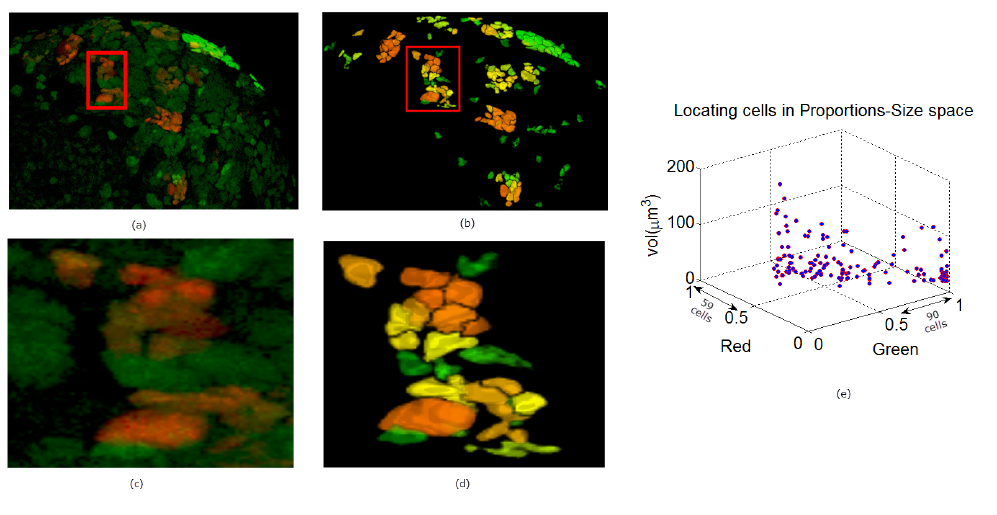
Figure 11. Panel ( a ) is a depiction of another MUTANT TYPE 2 larval brain nuclei in 3D volume in ZEN. In panel ( b ) the 3D reconstruction is shown. The noisy background (GFP) is separated from the true signals using the ACWE [3]. In panels ( c ) and ( d ) enlarged regions are shown from the original and reconstructed images. The clustering of the nuclei in panel ( e ) is based on the segmentation in panel ( a